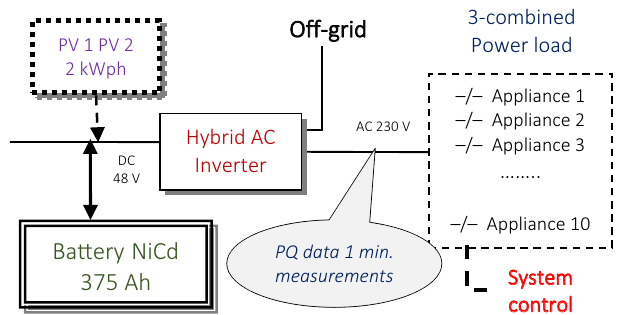
Figure 2. The off-grid with 10 power consumers (PV panels are not